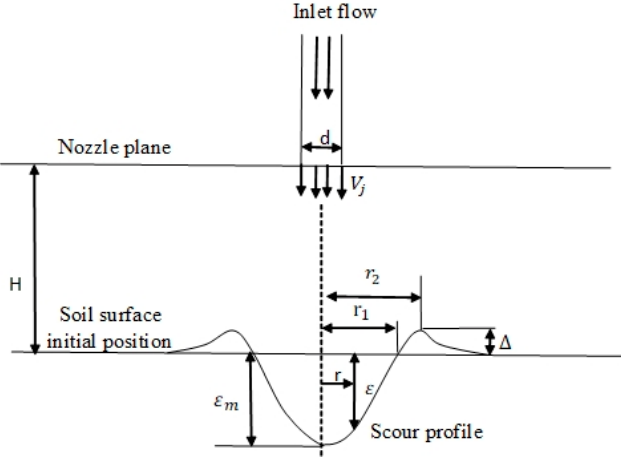
Figure 3. The schematic diagram of soil-breaking of vertical impinging